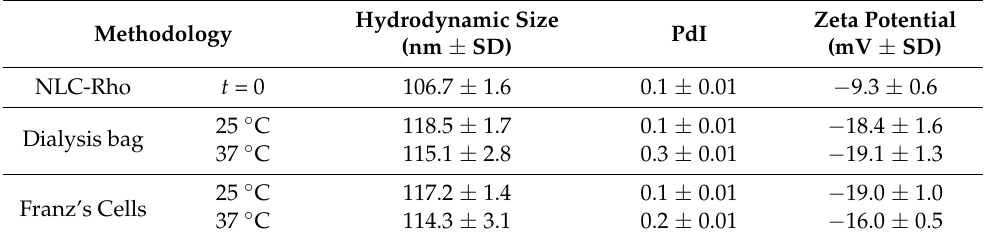
Table 4. Evaluation of NLC-Rho after release studies (72 h). Parameters evaluated were hydrody- namic size (nm), PdI and zeta potential (mV). n = 3 ± SD.